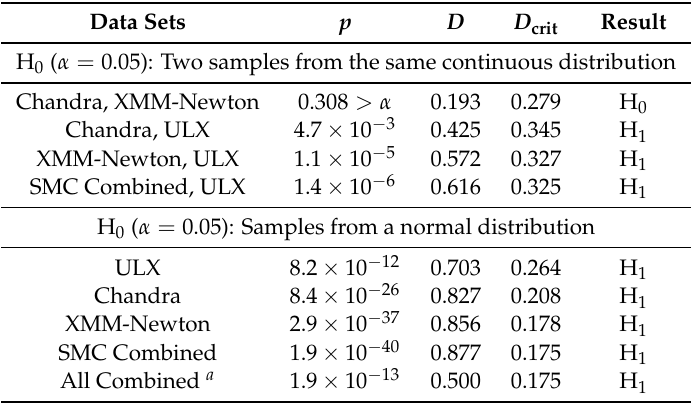
Table 4. Kolmogorov–Smirnov Tests.